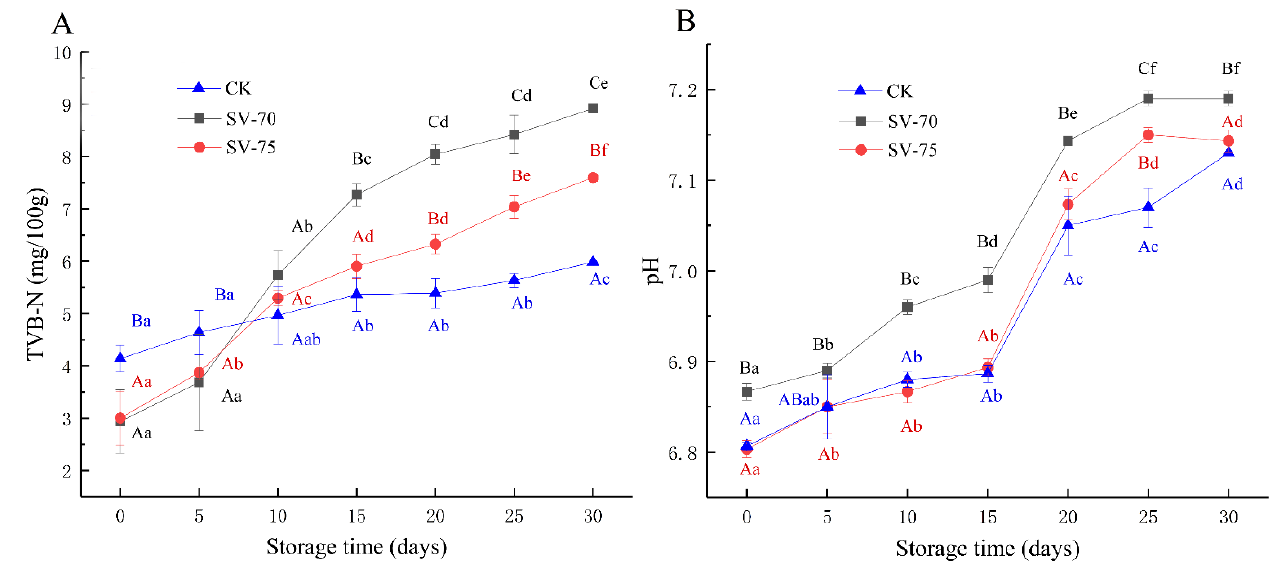
Figure 1. Changes in TVBN content ( A ) and pH value ( B ) of scallop samples with different treatments during 30 d of chilled storage. Different lowercase letters in the same color for the same point plot indicate significant difference ( p < 0.05), and different uppercase letters in the same storage time indicate significant difference ( p < 0.05).